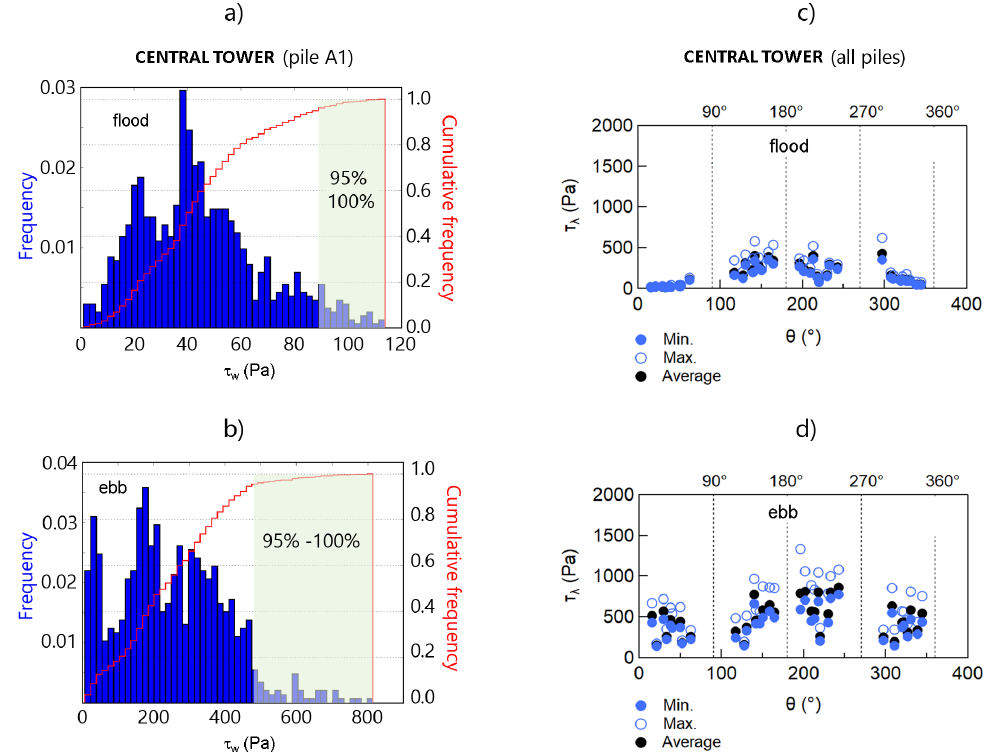
Figure 13. Frequency distribution of τ w ( t ) for pile A1, for t ∈ [ t ∗ , ∆ T ] for pile A1 (upper left pier in Figure 2b) of the CT site for ( a ) the flood-tide scenario ( b ) and the ebb-tide scenario. The cumulative frequency curve (in red) is also included. Distribution of τ λ versus the central angle θ (Figure 2c) for for ( c ) the flood-tide scenario ( d ) and the ebb-tide scenario. Minimum, maximum and the average of this parameter are shown for reference. Figures adapted from [29]. Table 4. Rate erosion ˙ r obtained from RETA tests for samples extracted from CT (samples: RR1, RR2, RR3, RR4 and